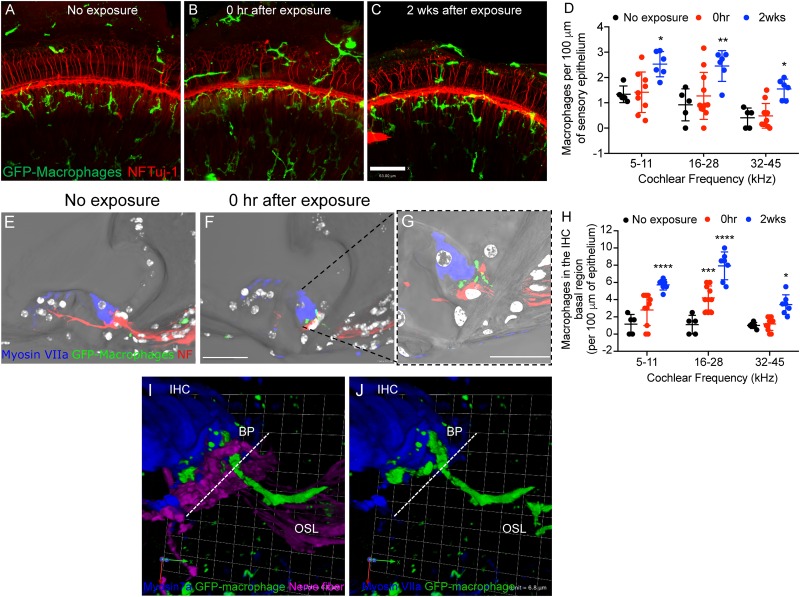
Macrophage migrate into the epithelium after noise trauma. Representative cochlear whole mount micrographs from CX3CR1+/- mice (A) not exposed to noise (no exposure), (B) at 0 h, and (C) 2 weeks after noise exposure immunolabeled for macrophages (green, GFP) and peripheral nerve fibers (red, NF165 and Tuj-1). (D) Macrophage numbers per 100 μm of sensory epithelium. No exposure (n = 5), 0 h (n = 11) and 2 weeks (n = 7). ∗p < 0.05, ∗∗p < 0.01, control vs. 2 weeks. (E) The organ of Corti from an unexposed mouse (no exposure) showing macrophages in the osseous spiral lamina away from the IHC-synaptic region. (F) GFP-macrophage observed in the basal region of an inner hair cell (Myosin VIIa, blue) at 0 h after noise exposure. (G) Higher magnification of (F) showing GFP-macrophage above the habenula and in the basal region of the IHC at 0 h after synaptopathic noise exposure. White color in E-G represents nuclei stained with DAPI. (H) Macrophage numbers in the IHC basal region per 100 μm of epithelium. No exposure (n = 5), 0 h (n = 11) and 2 weeks (n = 7).∗∗∗p < 0.001 (16–28 kHz), no exposure vs. 0 h, ∗∗∗∗p < 0.0001 (5–11, 16–28 kHz), ∗p < 0.05 (32–45 kHz), no exposure vs. 2 weeks. (I,J) 3D reconstruction of a confocal stack showing pseudopodia (cytoplasmic extension) of a GFP-macrophage above the habenula and under the basal pole (BP) of an inner hair cell (IHC, blue) and the cell body of the macrophage in the osseous spiral lamina (OSL). Dashed line represents demarcation of the organ of Corti from the OSL. Scale bar, 63 μm (A–C), 20 μm (E,F), 10 μm (G), and 6.8 μm (I,J).